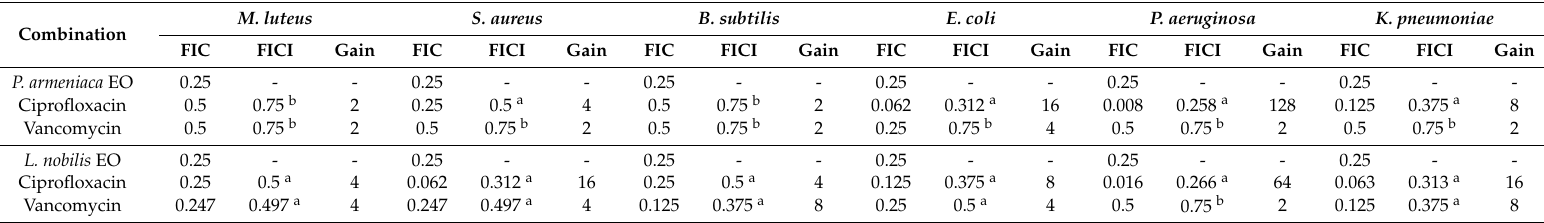
Table 4. Synergistic interaction between laurel ( L. nobilis ) and apricot ( P. armeniaca ) essential oils and ciprofloxacin against resistant bacteria. Combination